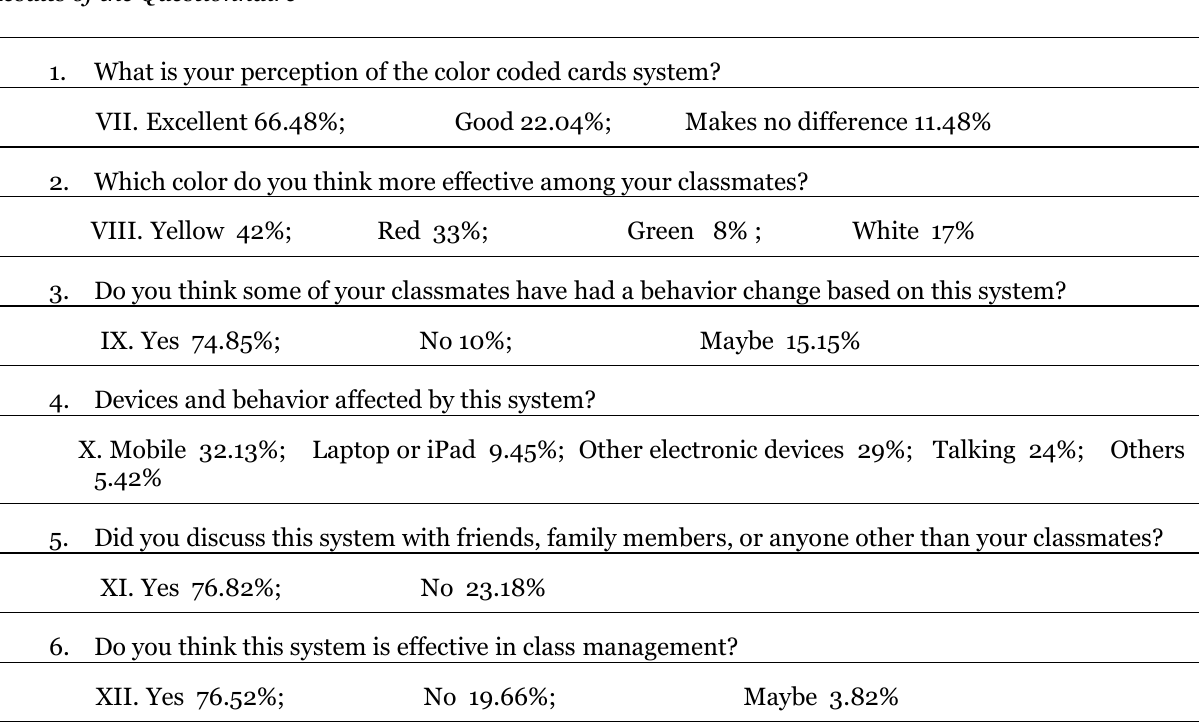
Results of the Questionnaire